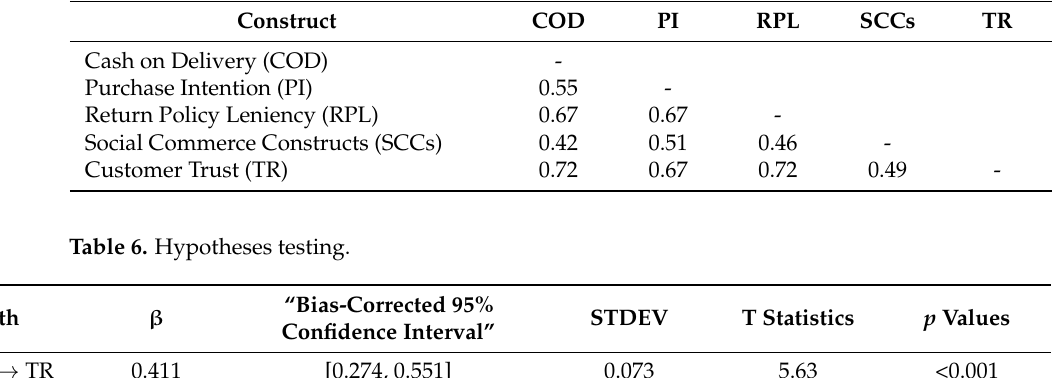
Table 5. HTMT text.